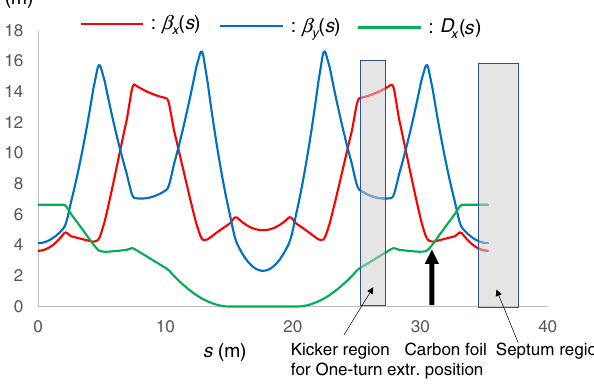
FIG. 2. Lattice functions and extraction device regions